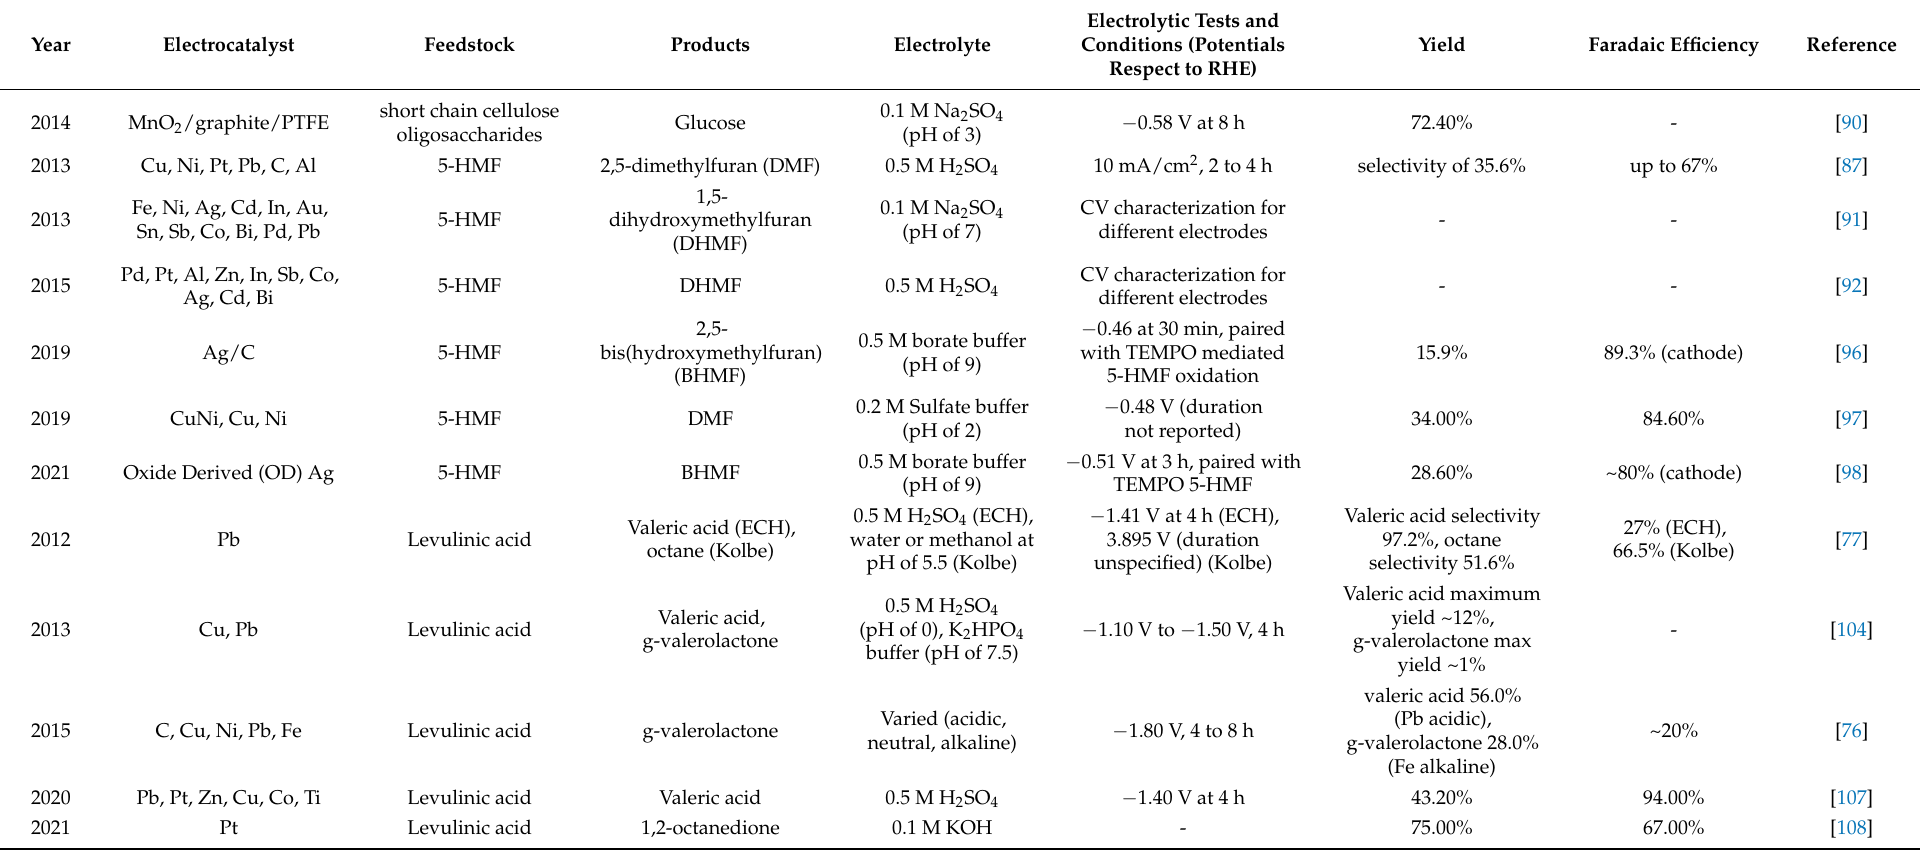
Table 2. Studies investigating electroreforming of biomass at the